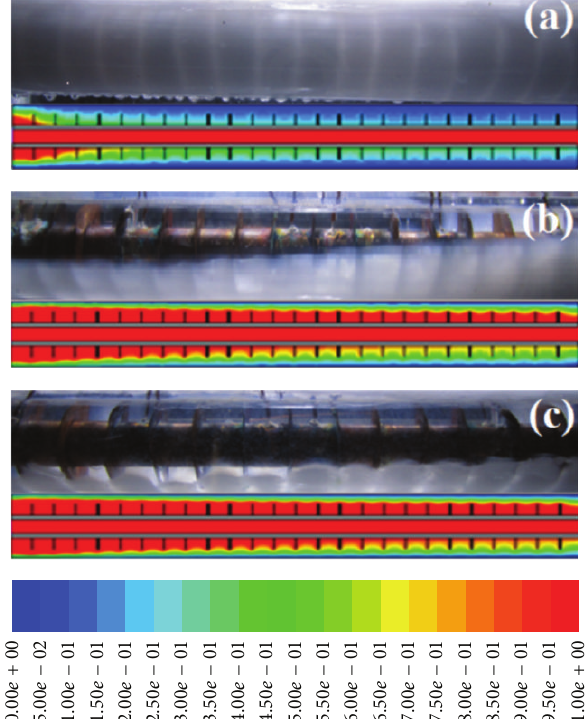
Figure 4: Melting process for Re = 1000 at (a) 1000 s, (b) 3500 s, and (c) 6000